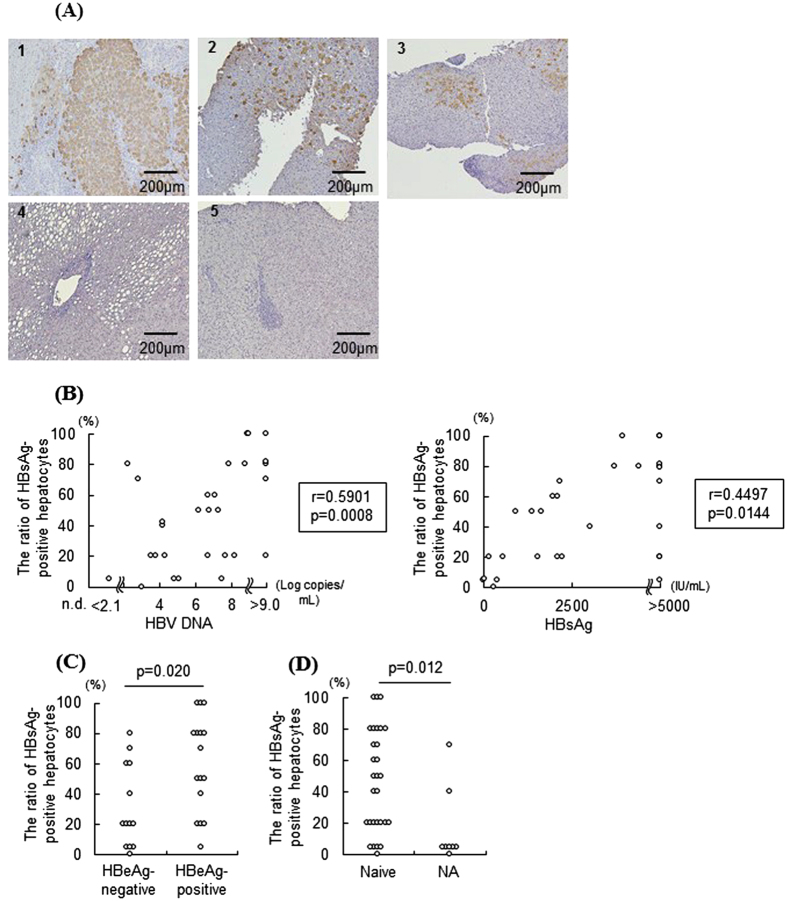
Liver samples from untreated CHB patients contained HBsAg-negative hepatocytes.Liver specimens obtained from 37 CHB patients (29 untreated CHB patients and 8 CHB patients on NAs) were stained with an anti-HBs antibody. (A) Representative images of liver specimens from patients with untreated CHB, non-alcoholic steatohepatitis or chronic hepatitis C (Table 2). (B) Pearson’s correlation coefficient was used to analyze the relation of the frequency of HBsAg-positive hepatocytes with serum HBV DNA or HBsAg levels in untreated CHB patients. HBV DNA levels that were detectable but below the lower limit of detection, which is 2.1, were given a value of 2.0. HBV DNA levels above the upper limit of limitation, which is 9.0, were given a value of 9.1. HBsAg levels above the upper limit of detection, which is 5000, were valued at 5001. (C) Comparison of the frequency of HBsAg-positive hepatocytes between HBeAg-negative (n = 13) and HBeAg-positive untreated CHB patients (n = 16) (Mann-Whitney U test). (D) Comparison of the frequency of HBsAg-positive hepatocytes in untreated CHB patients (naïve, n = 29) and in CHB patients on NAs (NA, n = 8) (Mann-Whitney U test).